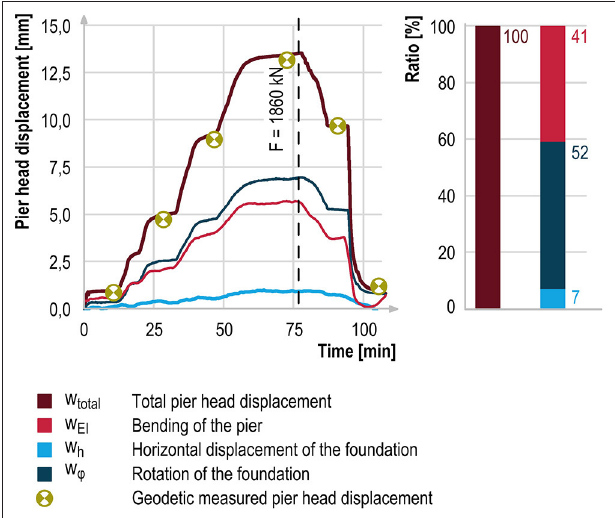
FIGURE 8 | Components of the pier head deformation at axis 20 (hydraulic presses located at axis